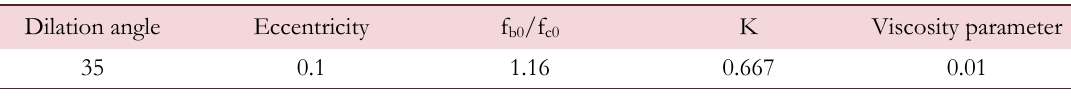
Table 4: Concrete damage plasticity (CDP) parameters adopted in the simulation.